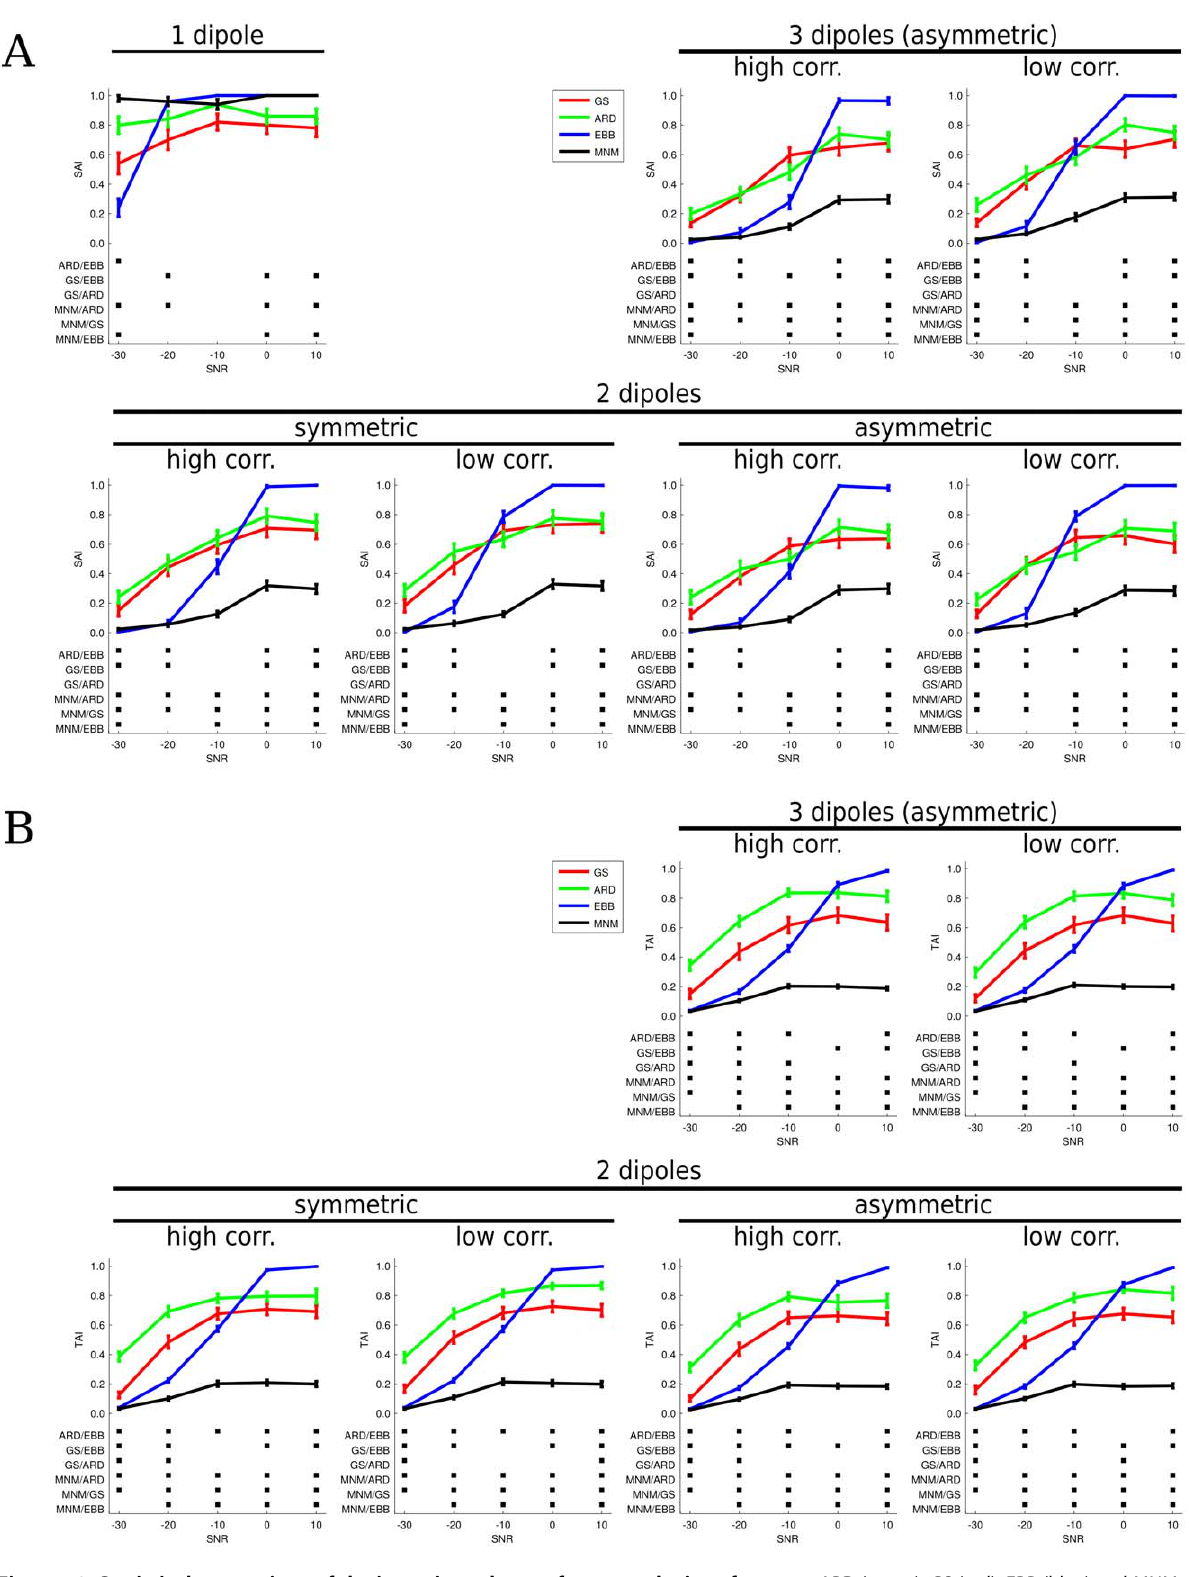
Figure 10. Statistical comparison of the inversion schemes for a search-size of 14 mm. ARD (green), GS (red), EBB (blue) and MNM results are plotted in Panel A (SAI results) and B (TAI results). For each simulation the mean accuracy index is plotted versus the different SNR levels. The error bars show the standard error. Black squares in the lower panels indicate significant difference between the schemes’ performances.